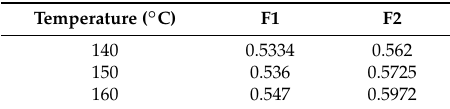
Figure 4. Temperature dependence of viscosity of the feedstocks.